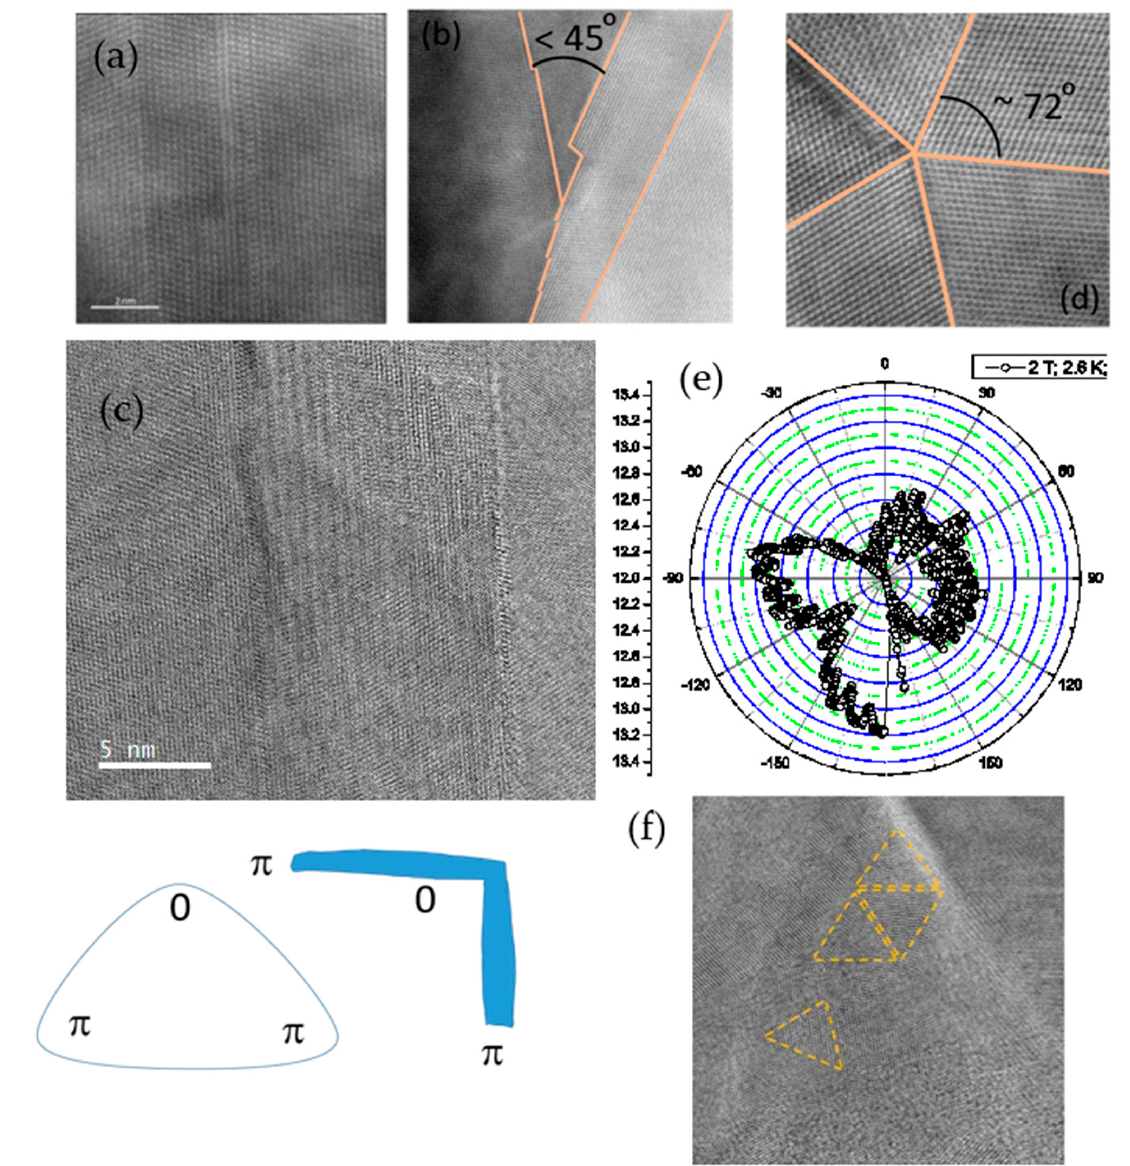
Figure 2. ( a ) UHR − TEM imaging of the HBDDF. The individual grains are highly ordered with clearly defined lattice planes. Grain boundaries are regular planes that span the length of the individual grains and define planes of crystal twinning. ( b ) The intersection of the grain boundaries occurs at 45 ◦ (when two twinned planes meet). ( c ) High-angle annular dark − field (HAADF) imaging allows for a more detailed structural analysis; the extended lattice is then dominated by stacking faults terminated by crystal twins. ( d ) It also shows higher-order intersections of fivefold symmetry oriented at approximately 72 ◦ apart and stacking fault layers where translational symmetry is broken. ( e ) Angle − dependent resistance (Ohm) in polar co-ordinate shows pronounced anisotropic features, with 72 ◦ as well as smaller periods, indicating grain boundary conduction. The critical temperature of the system is shifted to lower temperatures upon rotation in a small field. ( f ) A schematic indicating the effect lattice translational invariance and grain boundary mismatch can have on an anisotropic superconducting order parameter, as observed in the high T c cuprates, flipping of the pair potential can occur, this gives rise to bound states at the junction area. A triangular shape can introduce a π phase of the Cooper pairs. However, this can happen from the (111) plane (see discussion in the text). Lines are drawn to guide the